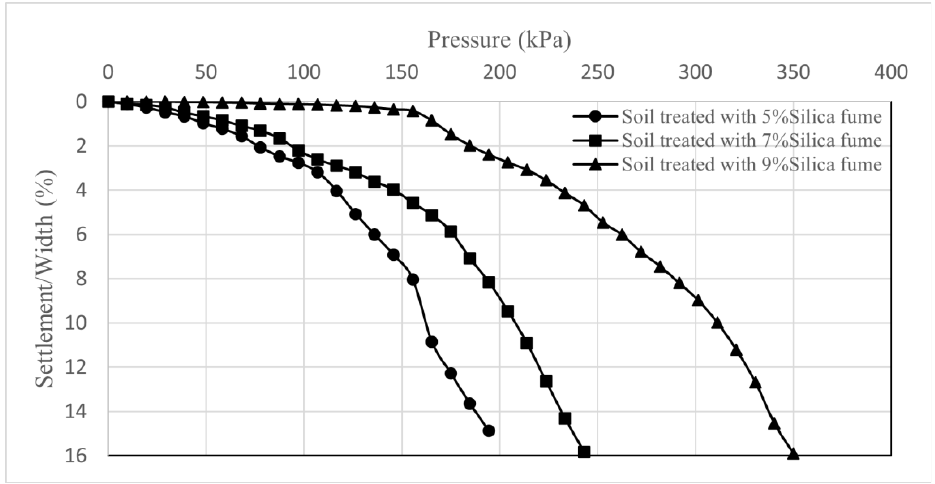
Figure 10. Pressure – settlement relationship for soil grouted with cement.